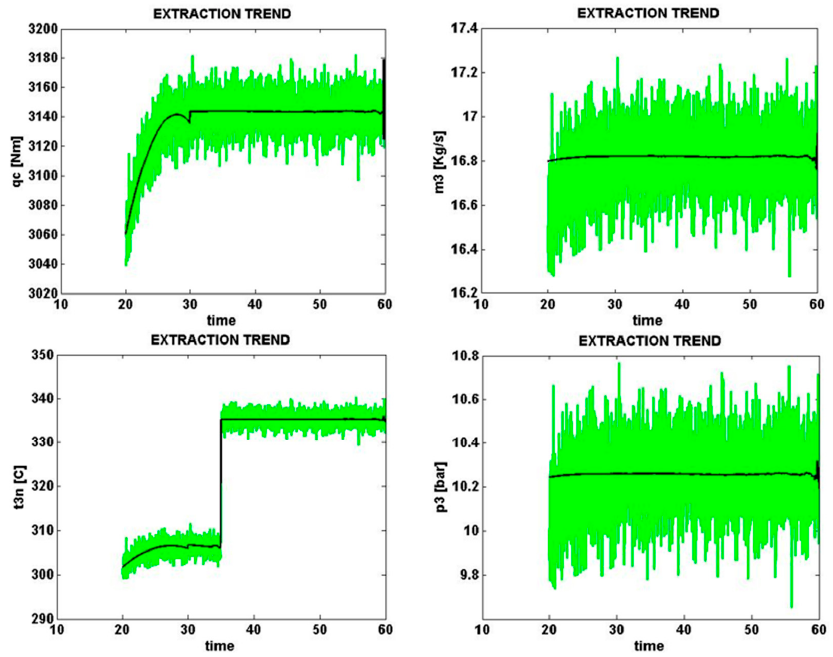
Figure 11. Error caused by a fault in the output voltage due to the occurrence of partial shadow, zero error rate (normal).